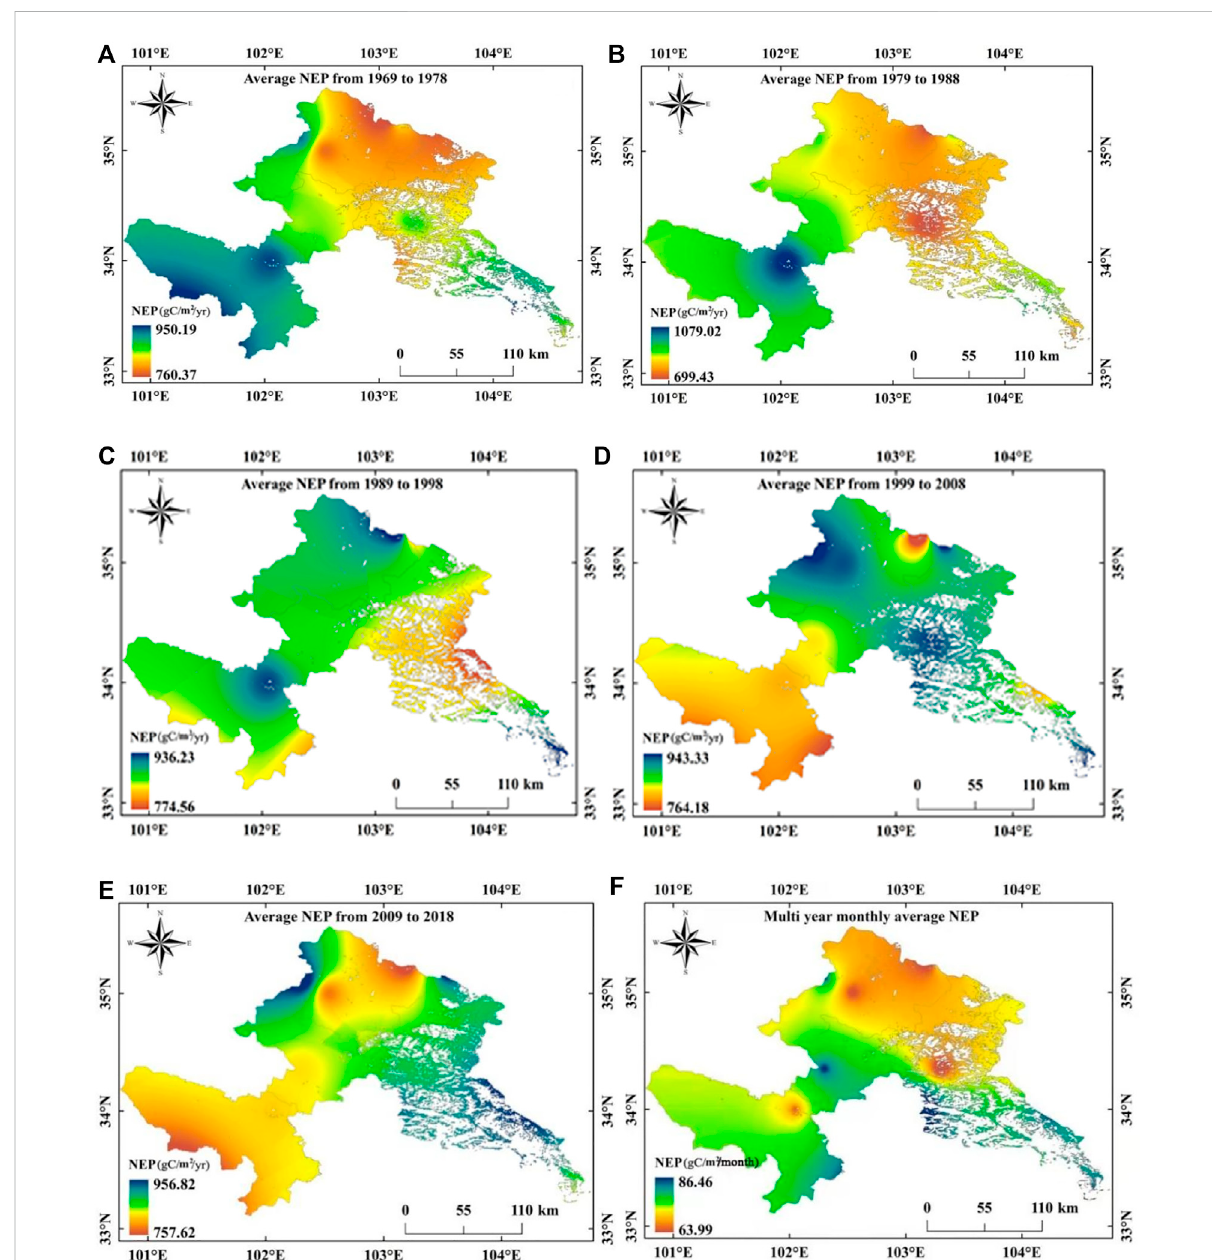
FIGURE 2 Spatial distribution of NEP of alpine meadows in Gannan, China, for the past 50 years. (A) From 1969 to 1978, (B) from 1979 to 1988, (C) from 1989 to 1998, (D) from 1999 to 2008, (E) from 2009 to 2018, and (F) monthly NEP from 1969 to